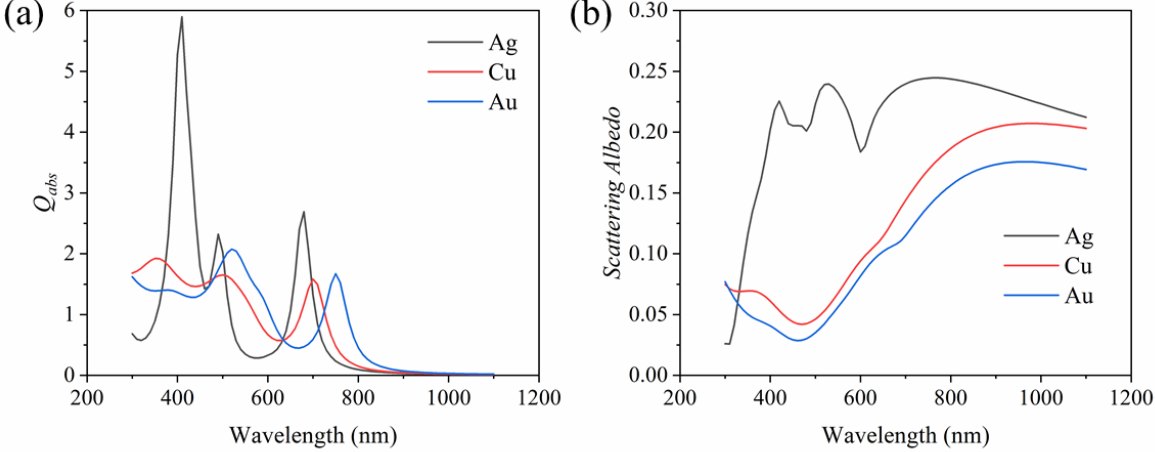
Figure 8. Effects of different metal materials on ( a ) absorption efficiency and ( b ) scattering albedo of dimer nanoparticle.